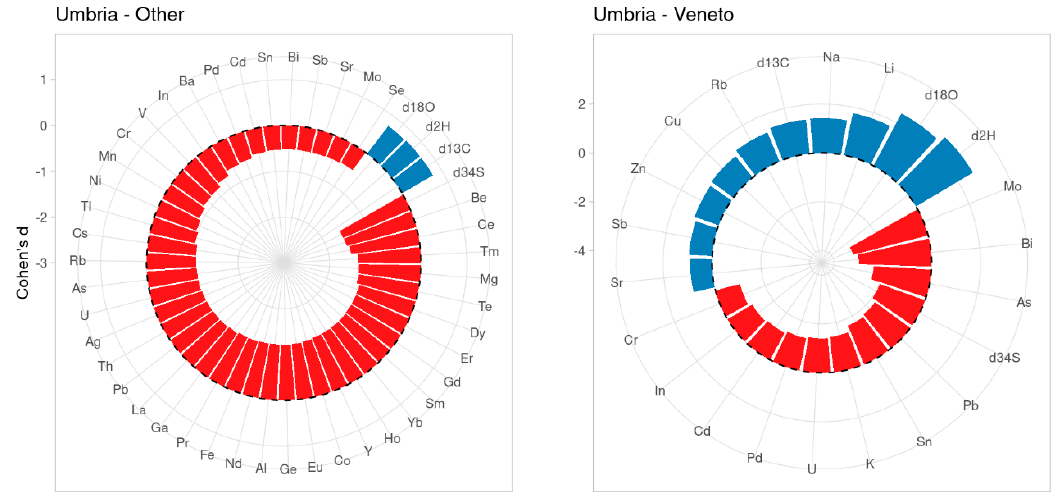
Figure 1. Plots of Cohen’s d effect size (standardized mean difference (SMD)) for tobacco leaves from Umbria, Veneto, and other geographical origin.